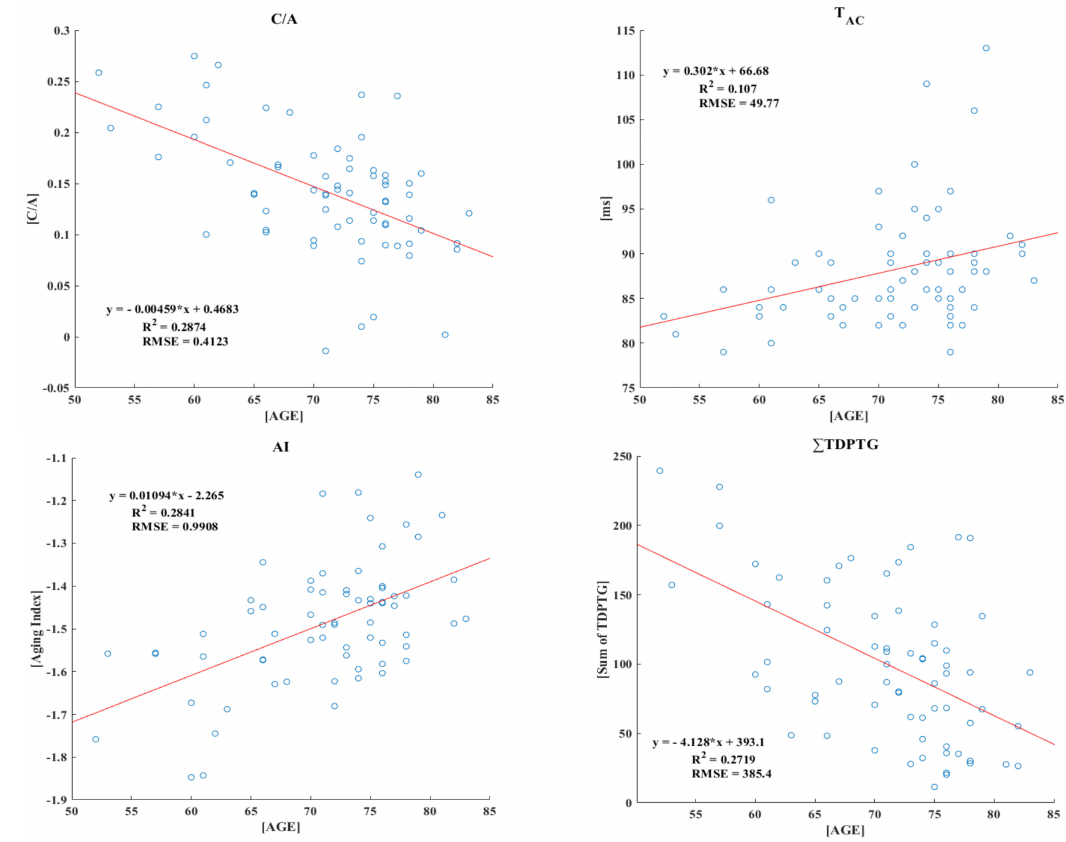
Figure 4. Scatter plot of the correlated variables with age.